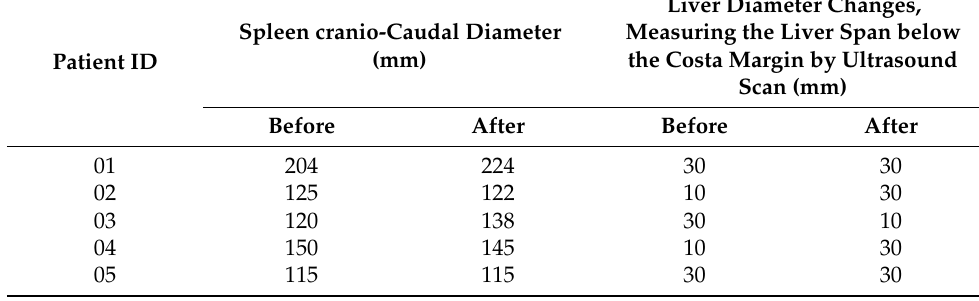
Table 1. Spleen and liver diameter changes pre-and post-treatment with trehalose. Liver Diameter Changes, Measuring Spleen cranio-Caudal Diameter the Liver Span below the (mm) Patient ID